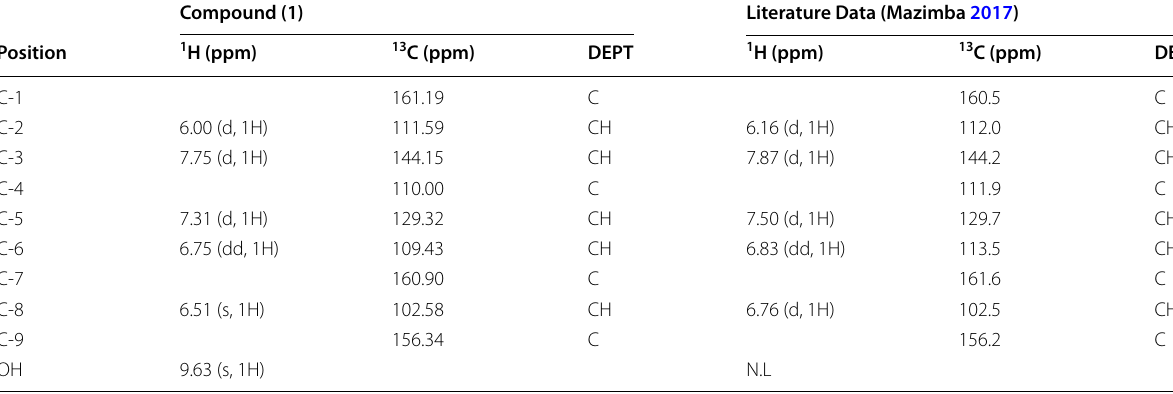
Table 1 The NMR (400 MHz) data of the compound (1)